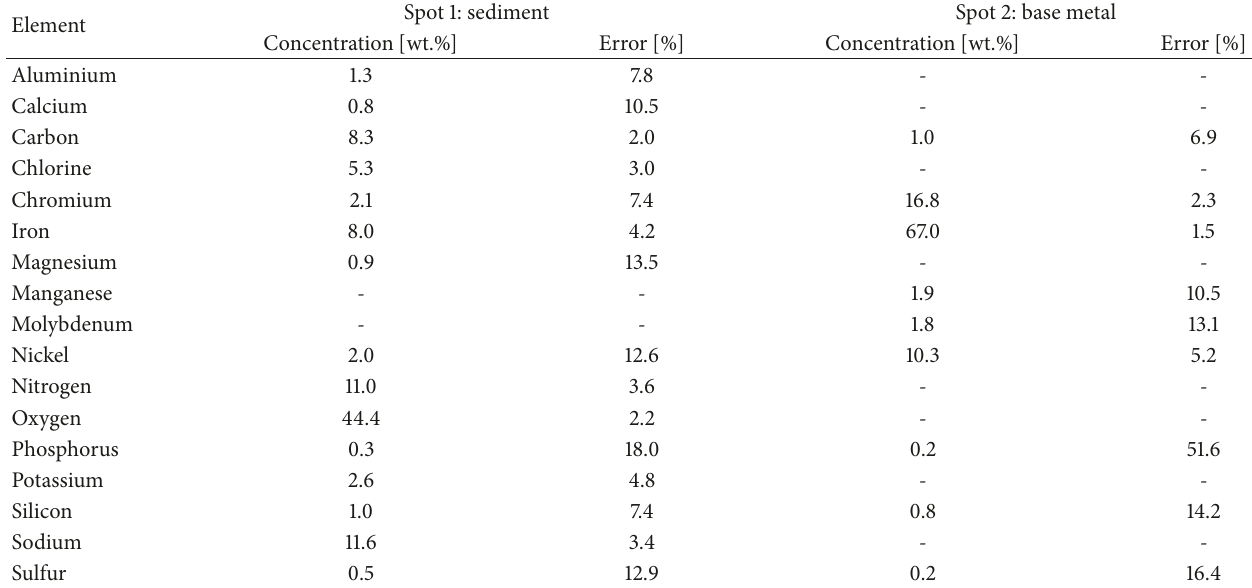
Table 2: The results of chemical composition analysis at spot 1 (sediment) and spot 2 (metal surface) in Figure 5. Spot 1: sediment Spot 2: base metal Element Concentration [ wt.% ] Error [ % ] Concentration [ wt.% ] Error [ % ] Aluminium 1.3 Calcium